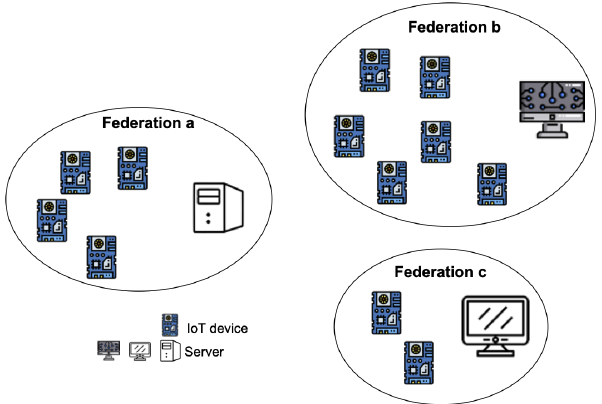
Figure 3. IoT system federations.